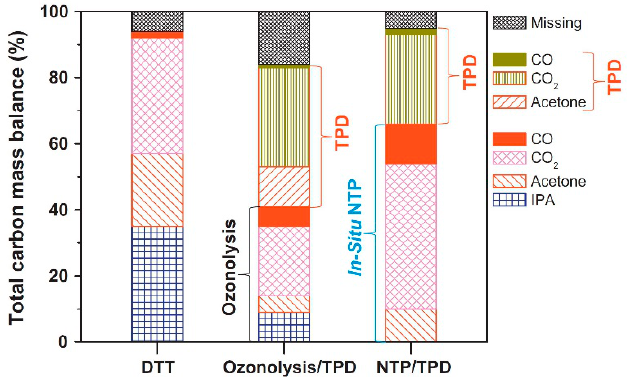
Figure 4. Comparison of adsorbed isopropanol (IPA) mineralization on Mn x O y surface using three different regeneration methods. Reprinted from Ref. [50], with permission from